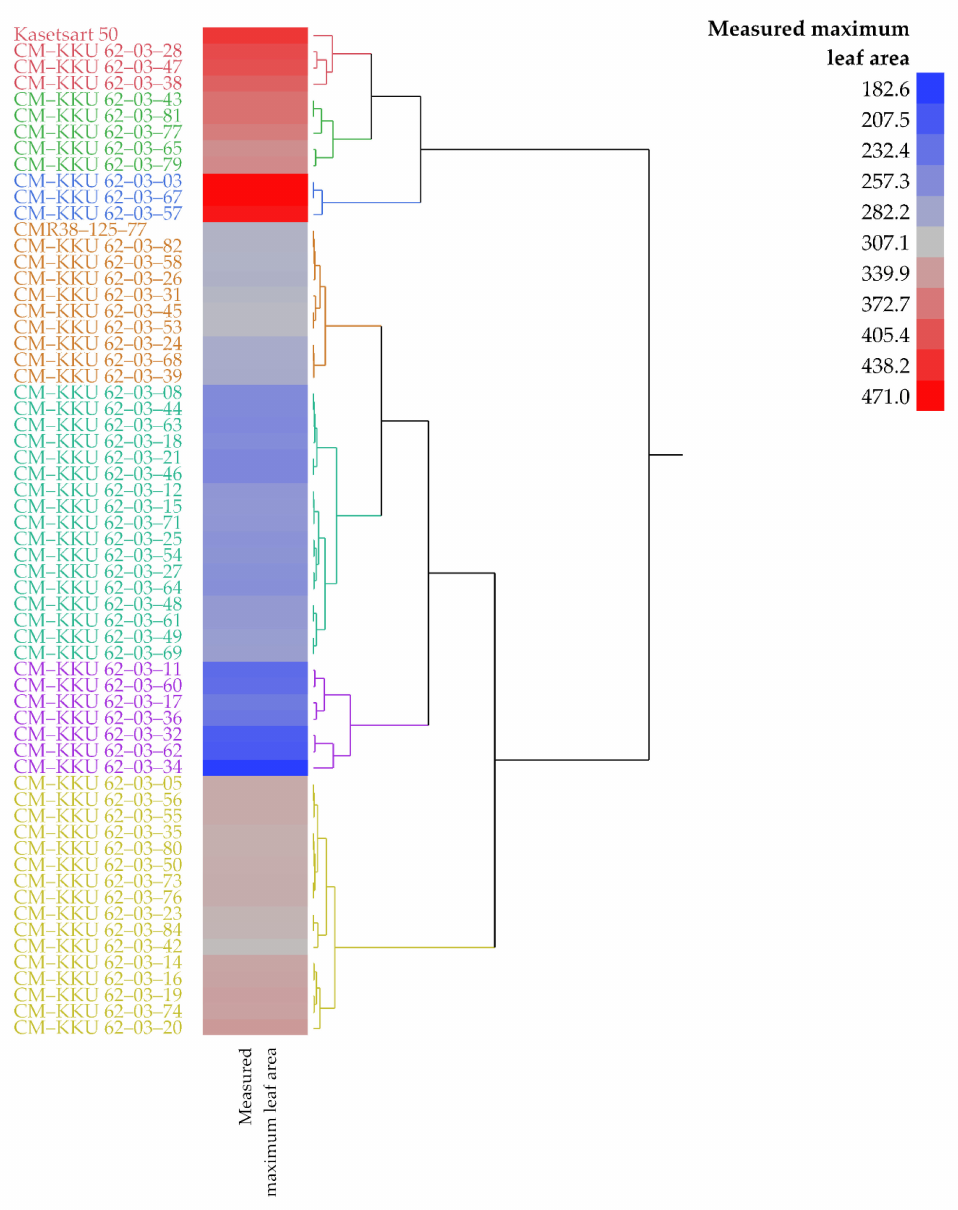
Figure 3. Dendrogram of Kasetsart 50 and CMR38–125–77 genotypes and 60 segregating progenies by Ward’s cluster analysis based on measured maximum individual leaf area (cm 2